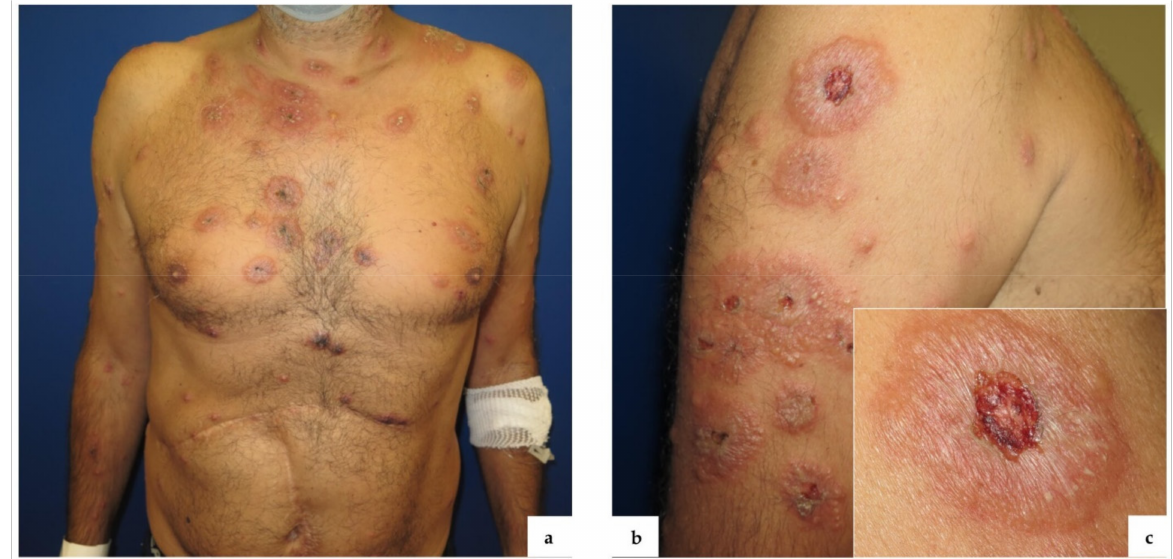
Figure 1. Well demarcated, targetoid lesions diffused to the trunk, neck ( a ), and upper limbs ( b ); BNT162b2 vaccine injection site ( c ).